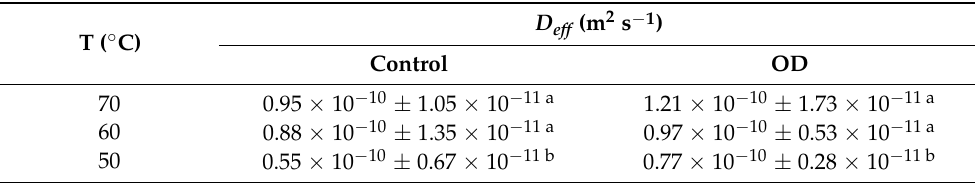
Table 2. Diffusion coefficients ( D eff ) at drying processing temperatures 50, 60, 70 ◦ C of air-dried OD pretreated (45 ◦ C, 90 min, 1/4 ratio of sample per OD solution ( w s / w OD )) and untreated (control)